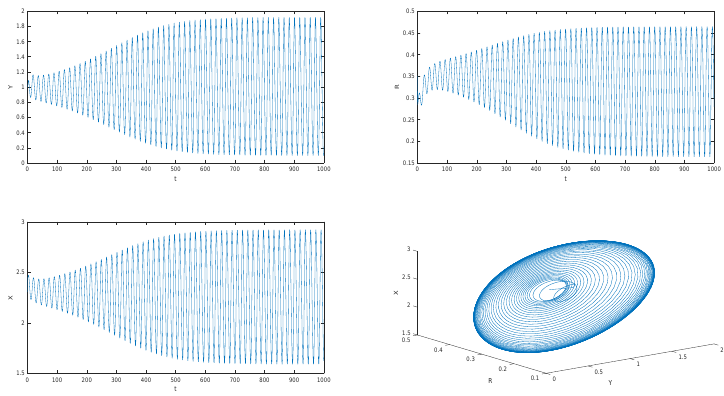
Figure 1. E ∗ is asymptotically stable, when α = 0.98, τ = 3.